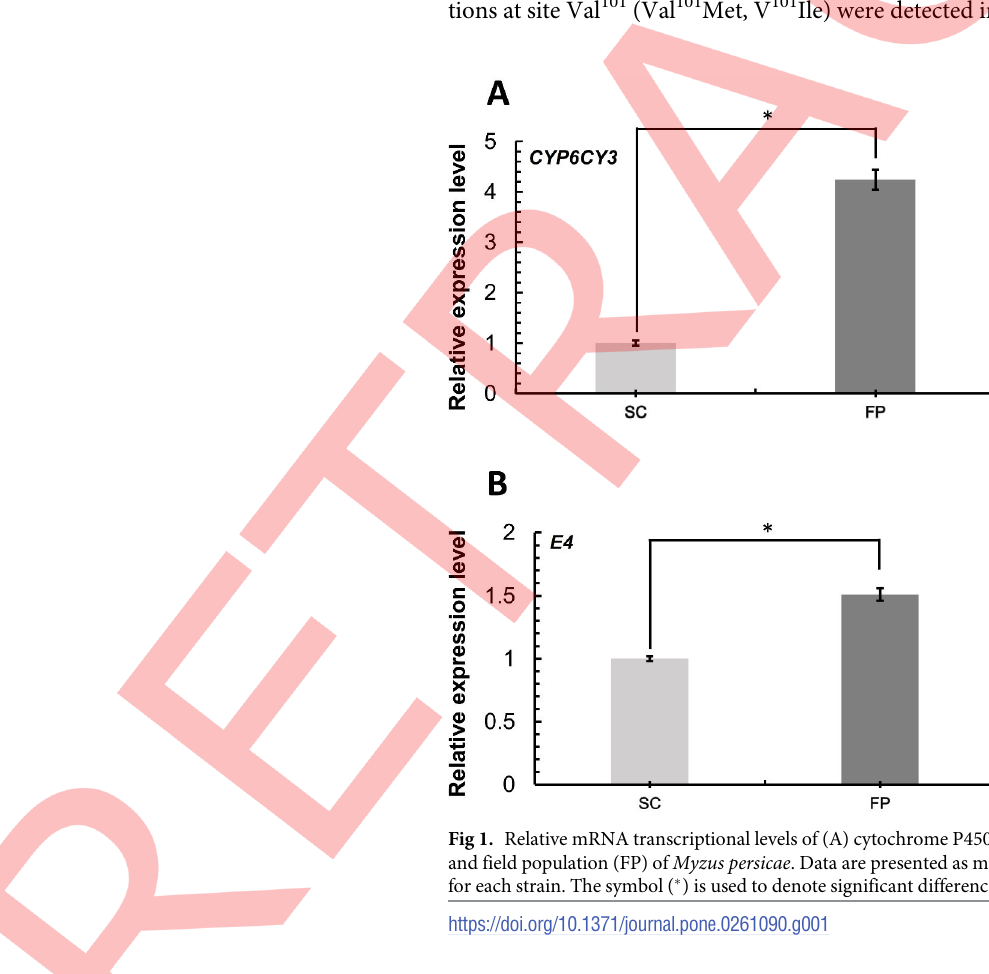
presence and frequencies of the R81T mutation in the loop D region of nAChR subunit β 1 in SC and FP were analyzed using direct cDNA sequencing (Table 4). A total 50 aphids of SC were observed in susceptible homozygous (SS). Among 50 aphids of FP, six were in homozy- gous resistant (RR), and fourteen aphids were present in the heterozygous form (SR). The resistance allele frequency (RAF) in FP was 26.0%. Additionally, two non-synonymous muta- tions at site Val 101 (Val 101 Met, V 101 Ile) were detected in D loop region of nAChR subunit β 1 of